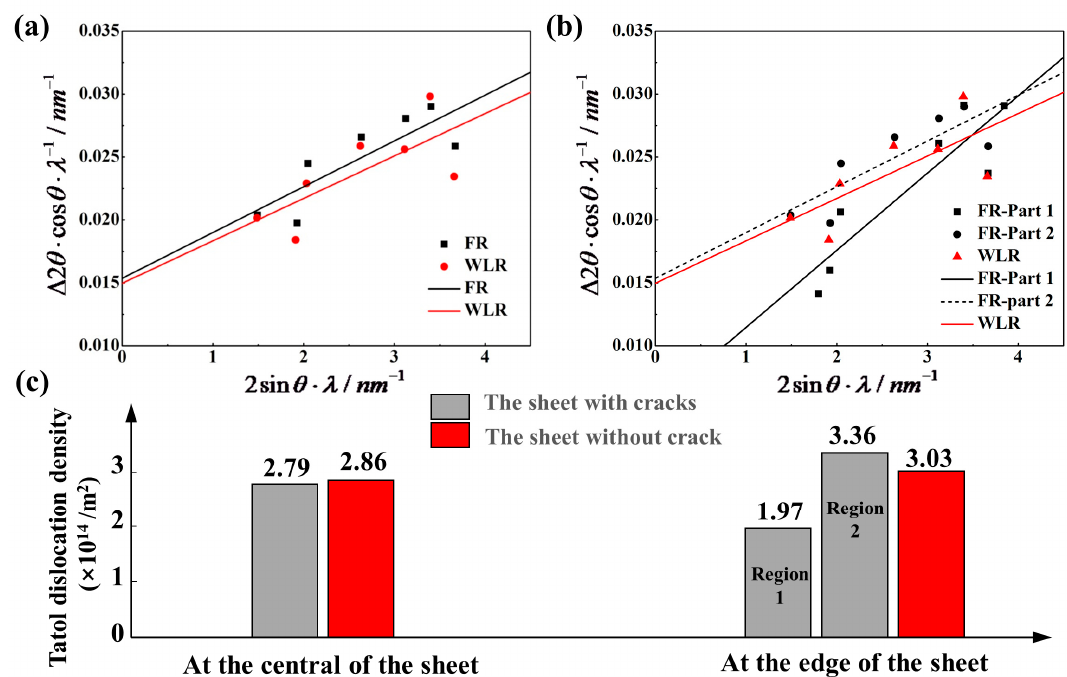
Figure 7. ( a , b ) Fit curve result of the sheets with cracks and without cracks. ( c ) Total dislocation density of different parts in the sheets without cracks and with cracks.